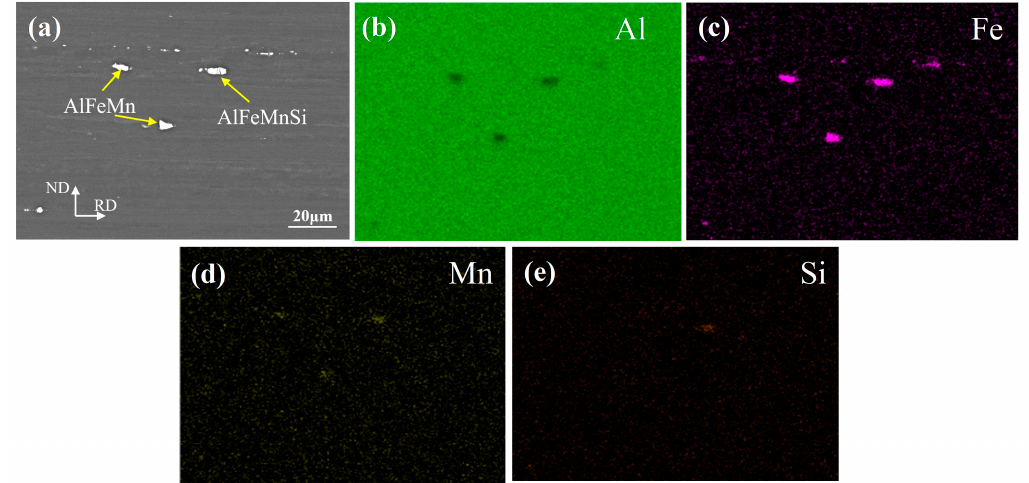
Figure 11. SEM image and elemental mapping results of the 7N01-T4 alloy ( a ); Al element ( b ); Fe element ( c ); Mn element ( d ); Si element ( e ).